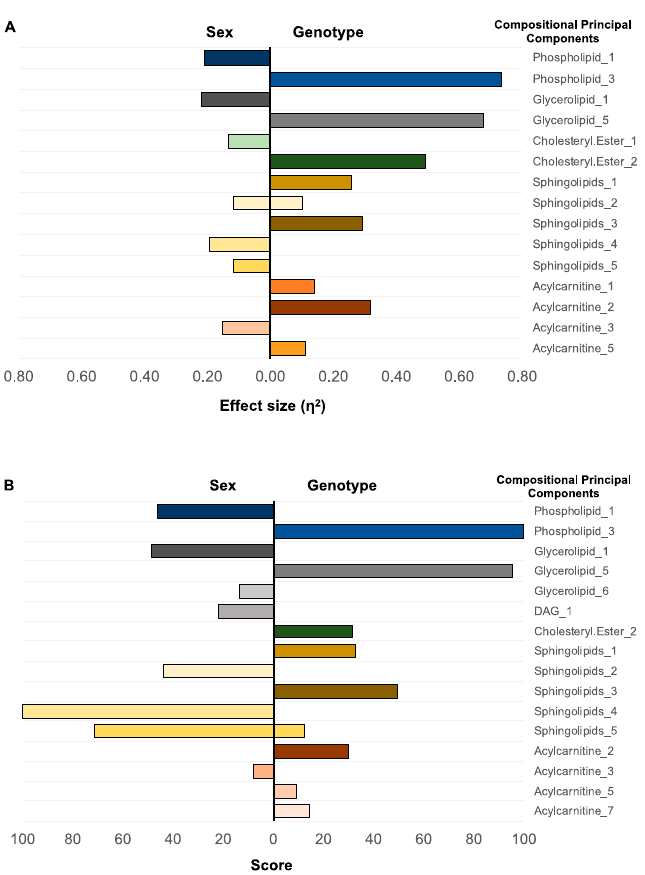
Figure 2. Importance of compressed categories for sex and genotype classification. ( A ) univariate linear model—selected lipid categories compositional principal component (CPC) based on their effect size ( η 2 ). ( B ) top 10 CPC of lipid categories ranked by the multivariate elastic net model for sex and genotype, which generate a prediction accuracy of 76% for the sex and 100% for the genotype.